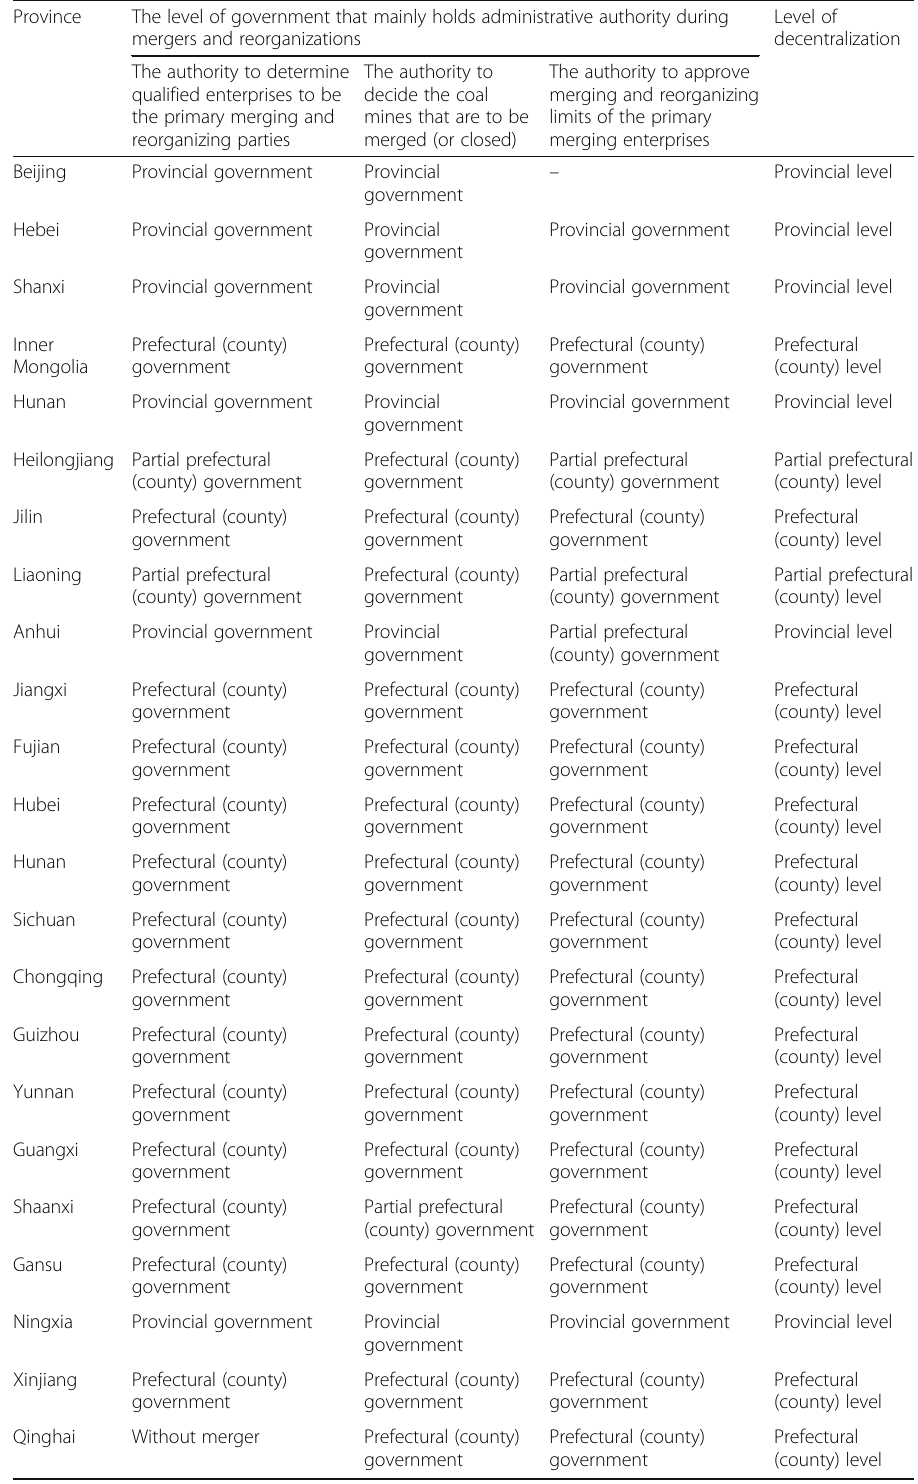
Table 5 Level of decentralization in each